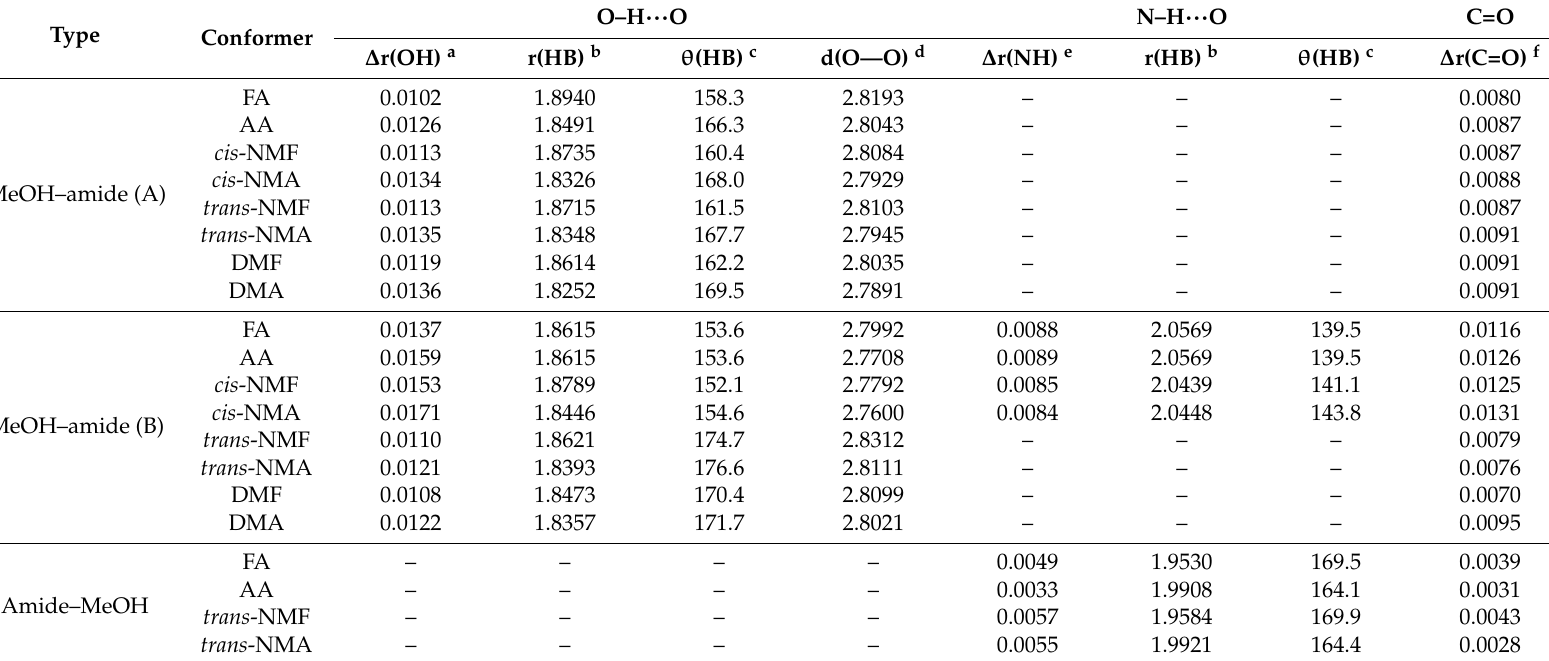
Table 1. Selected optimized geometric parameters in the O–H ··· O, N–H ··· O and C=O of the hydrogen bonded MeOH–amide and amide–MeOH complexes at